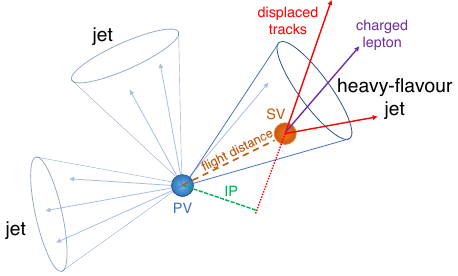
Figure 1. Illustration of heavy-flavour jet production with an SV